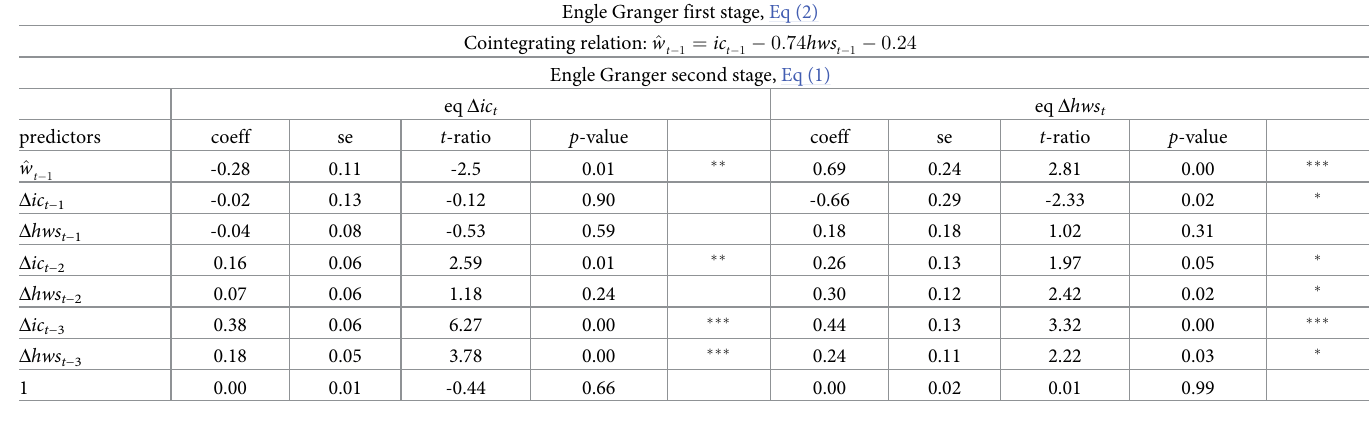
Table 1. Estimates for the d (1, 1) model for Lombardy, estimation period March 2 to March 29 2020.